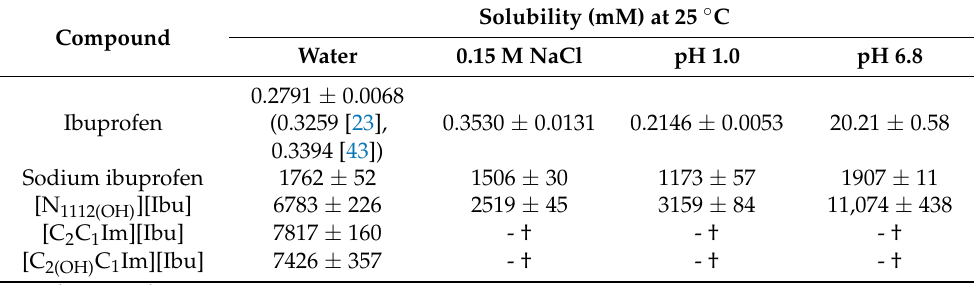
Table 4. Solubility of ibuprofen, sodium ibuprofen and ibuprofen-based ILs in water and the solu- bility of ibuprofen, ibuprofen sodium and cholinium-based API-IL in buffer solutions suitable for dissolution testing, isotonic ionic strength aqueous solution (0.15 M NaCl), simulated gastric fluid (pH 1.0) and simulated intestinal fluid (pH 6.8). All experiments were performed at 25 ◦ C ± 0.1 ◦ C. The solubility was the overall mean of at least two independent experiments ± standard